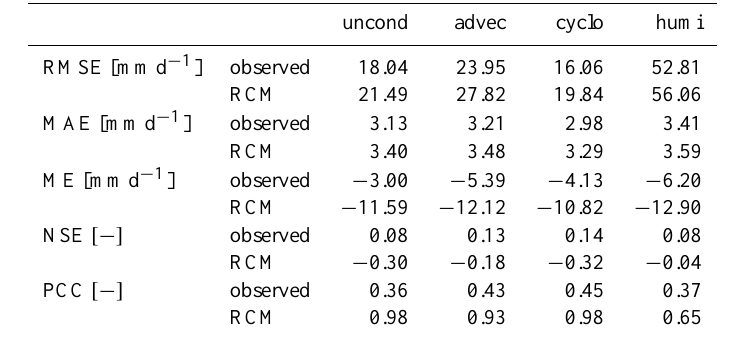
Table 6. Performance measures between positive pairs of pseudo-observations (mean value) produced by Copula-based stochastic simu- lations without using large-scale information (uncond), including advection (advec), cyclonality (cyclo), and humidity (humi) of the tro- posphere, and the observed precipitation at station Garmisch-Partenkirchen and the corresponding grid cell precipitation of RCM (RMSE – Root mean squared error; MAE – Mean absolute error; ME – Mean error; NSE – Nash-Sutcliffe efficiency; PCC – Pearson correlation